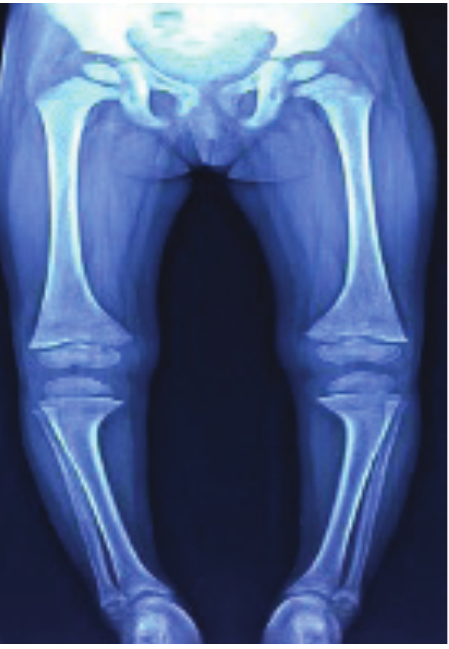
Figure 3a - AP X-ray of 4 year old child showing curved tibia – Sabre tibia- with signs of